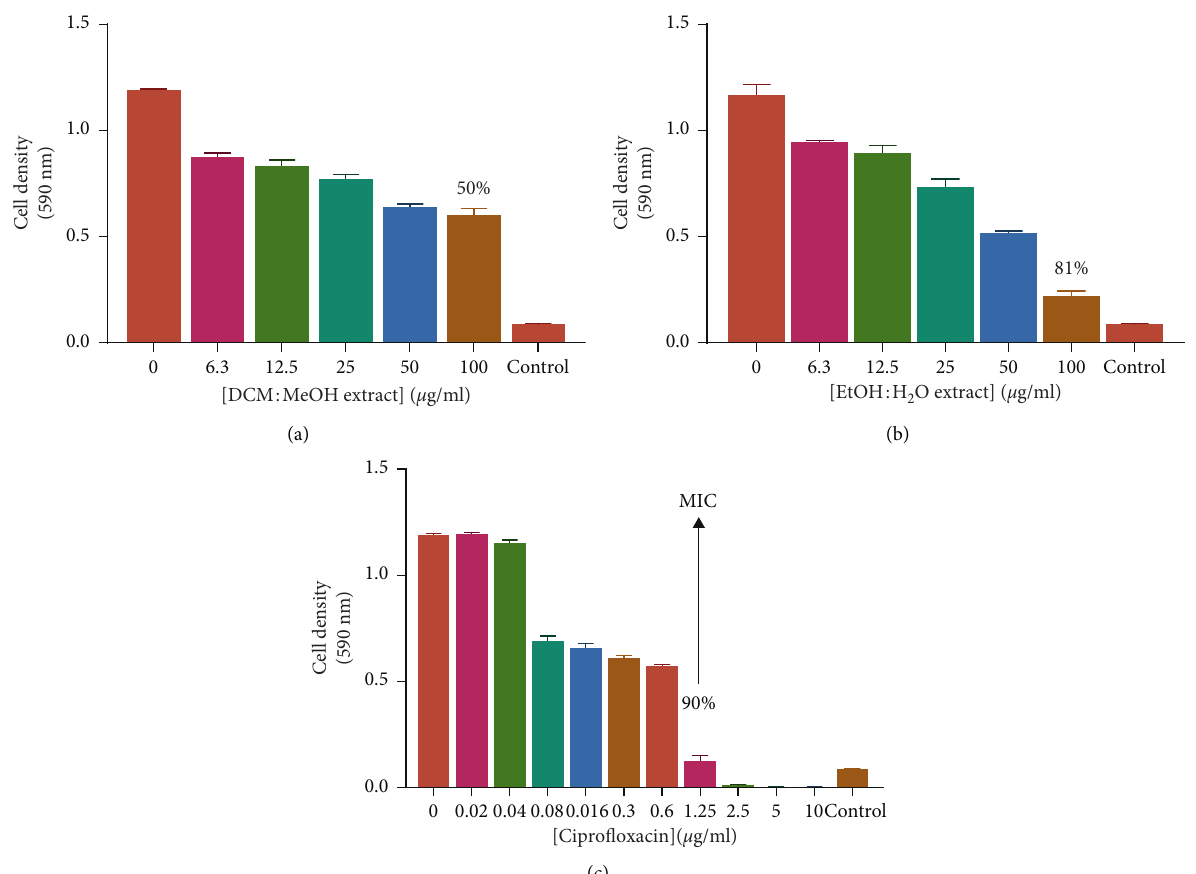
Figure 1: The effects of exposing on K. pneumoniae to extracts from Callistemon viminalis . Results of the microbroth dilution assay results are shown for (a) DCM:MeOH extract, (b) EtOH:H 2 O extract, and (c) ciprofloxacin. The error bars represent standard deviation from the mean of 4 repeat